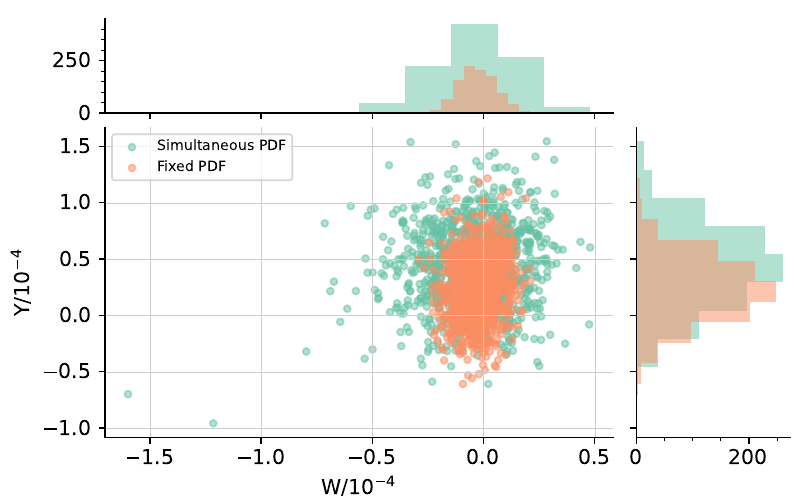
Figure 8 . Scatter plot for best fit tuples of ( W, Y ) for each replica obtained in the simultaneous fit (green) compared to those obtained when PDFs are kept fixed to the SM baseline (orange). The upper and rightmost panels are histograms in their respective directions. SM PDFs SMEFT PDFs best-fit shift broadening W × 10 5 (68% C.L.) [ − 1 . 1 , 0 . 5] [ − 2 . 4 , 1 . 5] − 0 . 2 +144 % W × 10 5 (95% C.L.) [ − 2 . 0 , 1 . 4] [ − 4 . 3 , 3 . 4] − 0 . 2 +126 % Y × 10 5 (68% C.L.) Y × 10 5 (95% C.L.) Table 2 . Same as table 1 for the 68% C.L. and 95% C.L. marginalised bounds on the W and Y parameters obtained from the two-dimensional ( W, Y ) fits that include the HL-LHC pseudo-data for NC and CC Drell-Yan